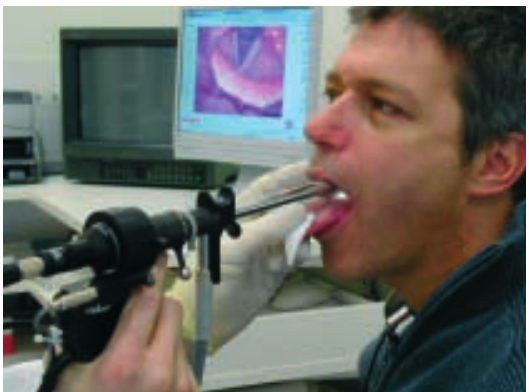
Video-laryngostrobo- scopy.